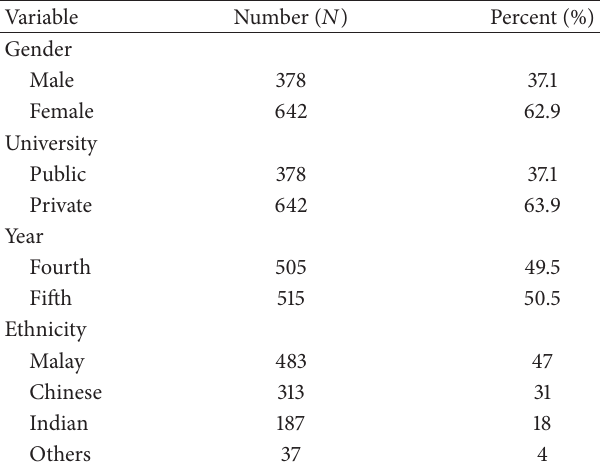
Table 1: Demographic characteristics of survey respondents ( 𝑁 = 1020